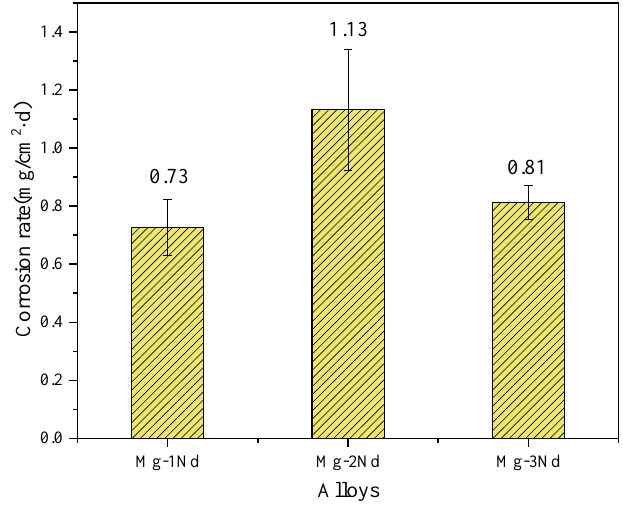
Figure 4. Corrosion rate of F-state Mg-Nd alloy after immersion for 7 days.